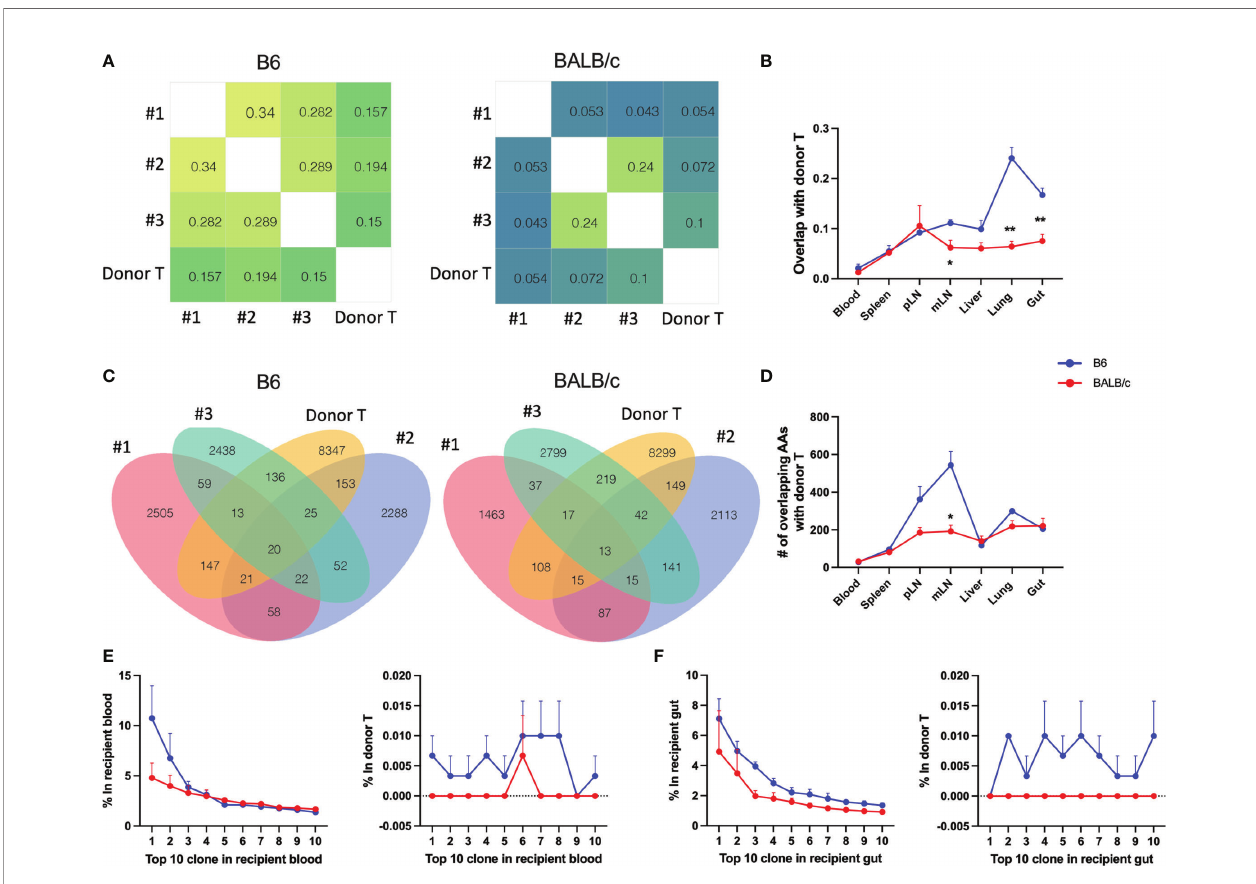
FIGURE 4 | Trace back of post-transplant from pre-transplant donor T cells. Heatmap shows the overlap metric between pre-transplant donor T cells and gut T cells in an individual recipient on day 7 after BMT (A) . Overlap metric with pre-transplant donor T cells were further analyzed in different tissues (B) . Number of overlapped CDR3 AAs between pre-transplant donor T cells and gut T cells (C) and T cells in indicated tissues (D) is shown. The frequency of top 1 – 10 CDR3 AAs from recipient blood ( E , left) and the frequency of these same CDR3 AAs in pre-transplant donor T cells ( E , right). The frequency of top 1 – 10 CDR3 AAs from recipient gut ( F , left) and the frequency of these same CDR3 AAs in pre-transplant donor T cells ( F , right). *p < 0.05, **p <